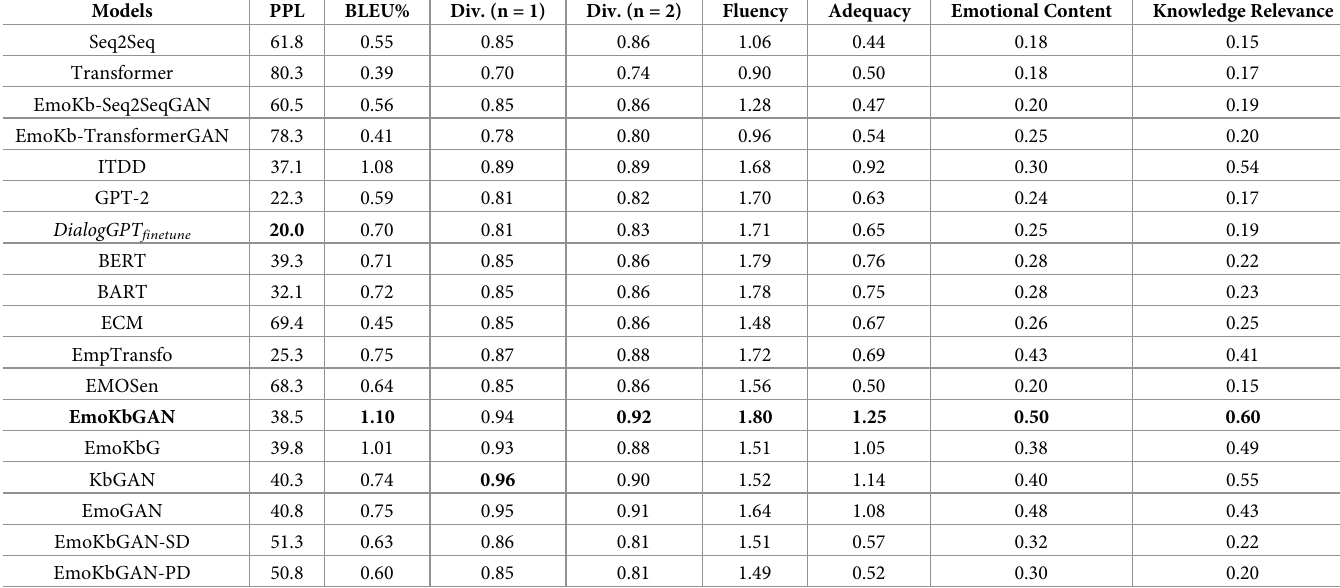
Table 5. Evaluation results using automatic and human evaluation metrics for baselines, ablation, and our proposed model on the CMU_DoG dataset. Models PPL